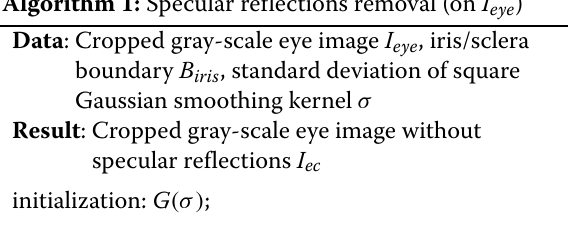
Algorithm 1: Specular reflections removal (on I eye )